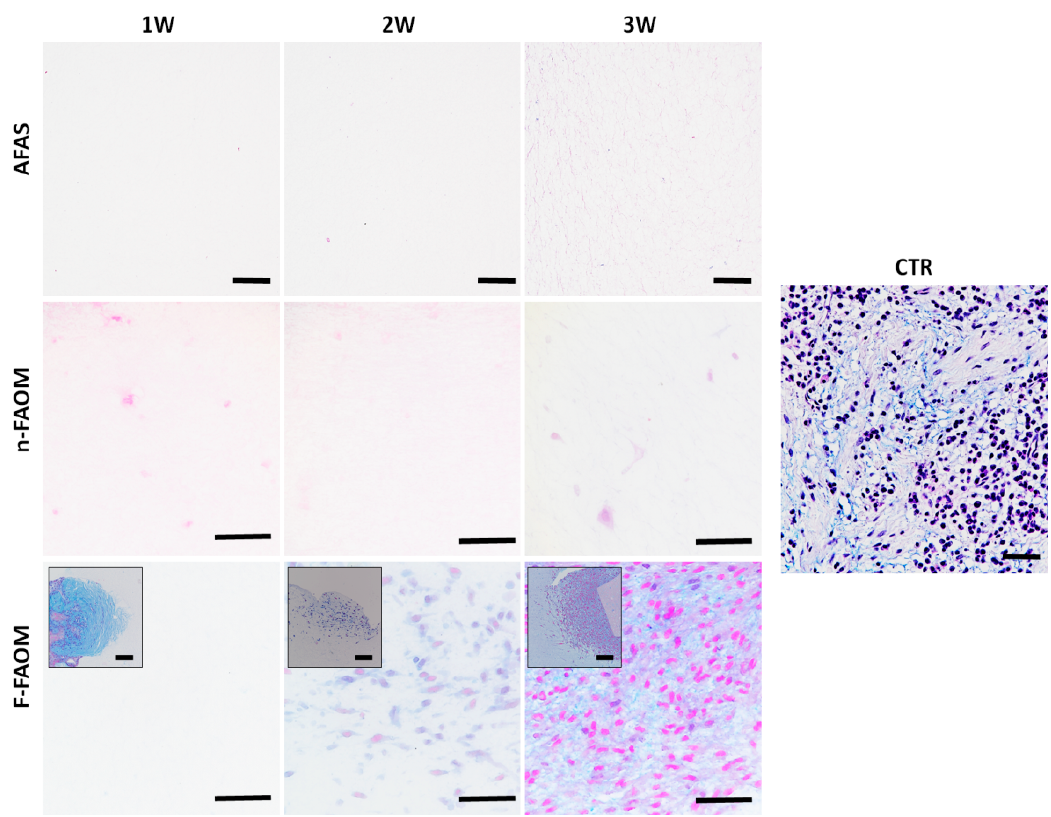
Figure 3. Histochemical analysis of controls and biofabricated oral tissues using Alcian Blue staining.